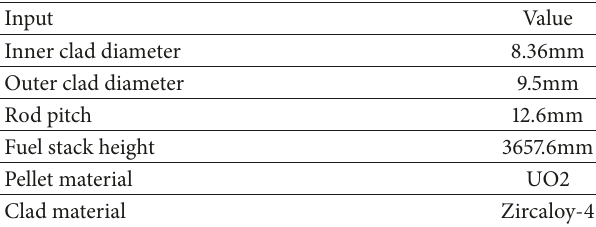
Table 1: Fuel rod specification [30].